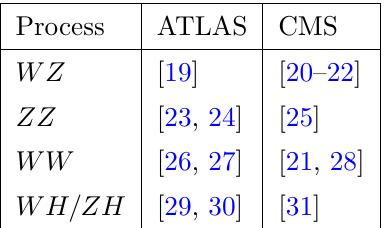
Table 1 . Experimental publications for boson pair production at 13 TeV